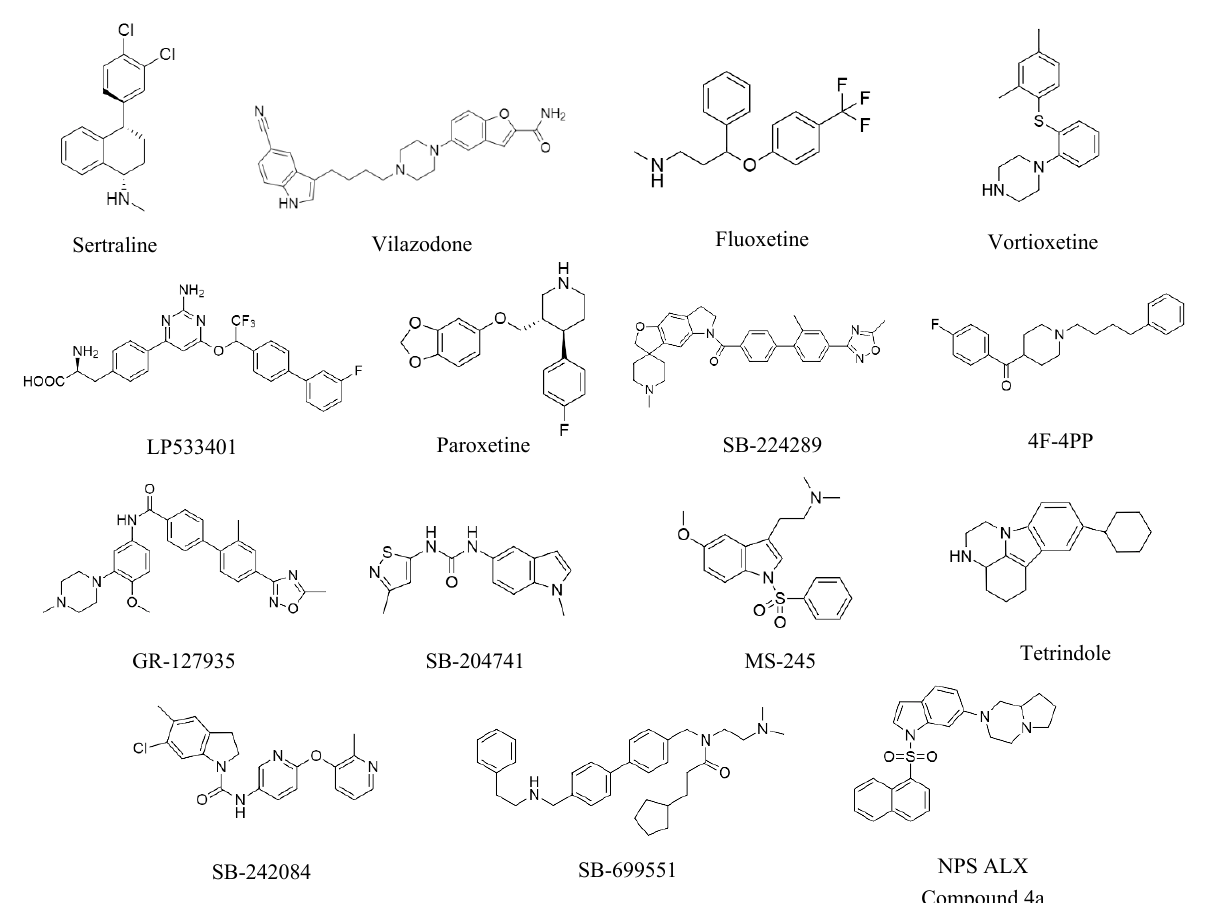
Figure 2. Chemical structures of serotonergic antagonists